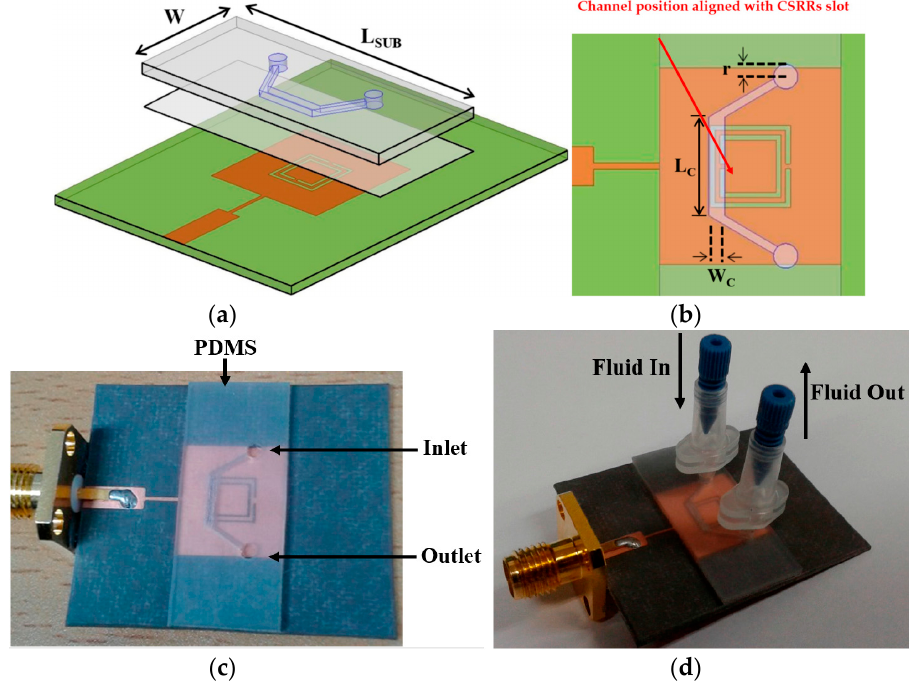
Figure 3. ( a ) Bird’s-eye view of the CSRR-loaded patch with an adhesive film and a microfluidic channel (top layer); ( b ) zoom-in view of channel alignment with CSRRs; ( c ) fabricated prototype of CSRR-loaded microfluidic patch as ethanol chemical sensor; and ( d ) side view with nanoport assembly (Redrawn from [4]).